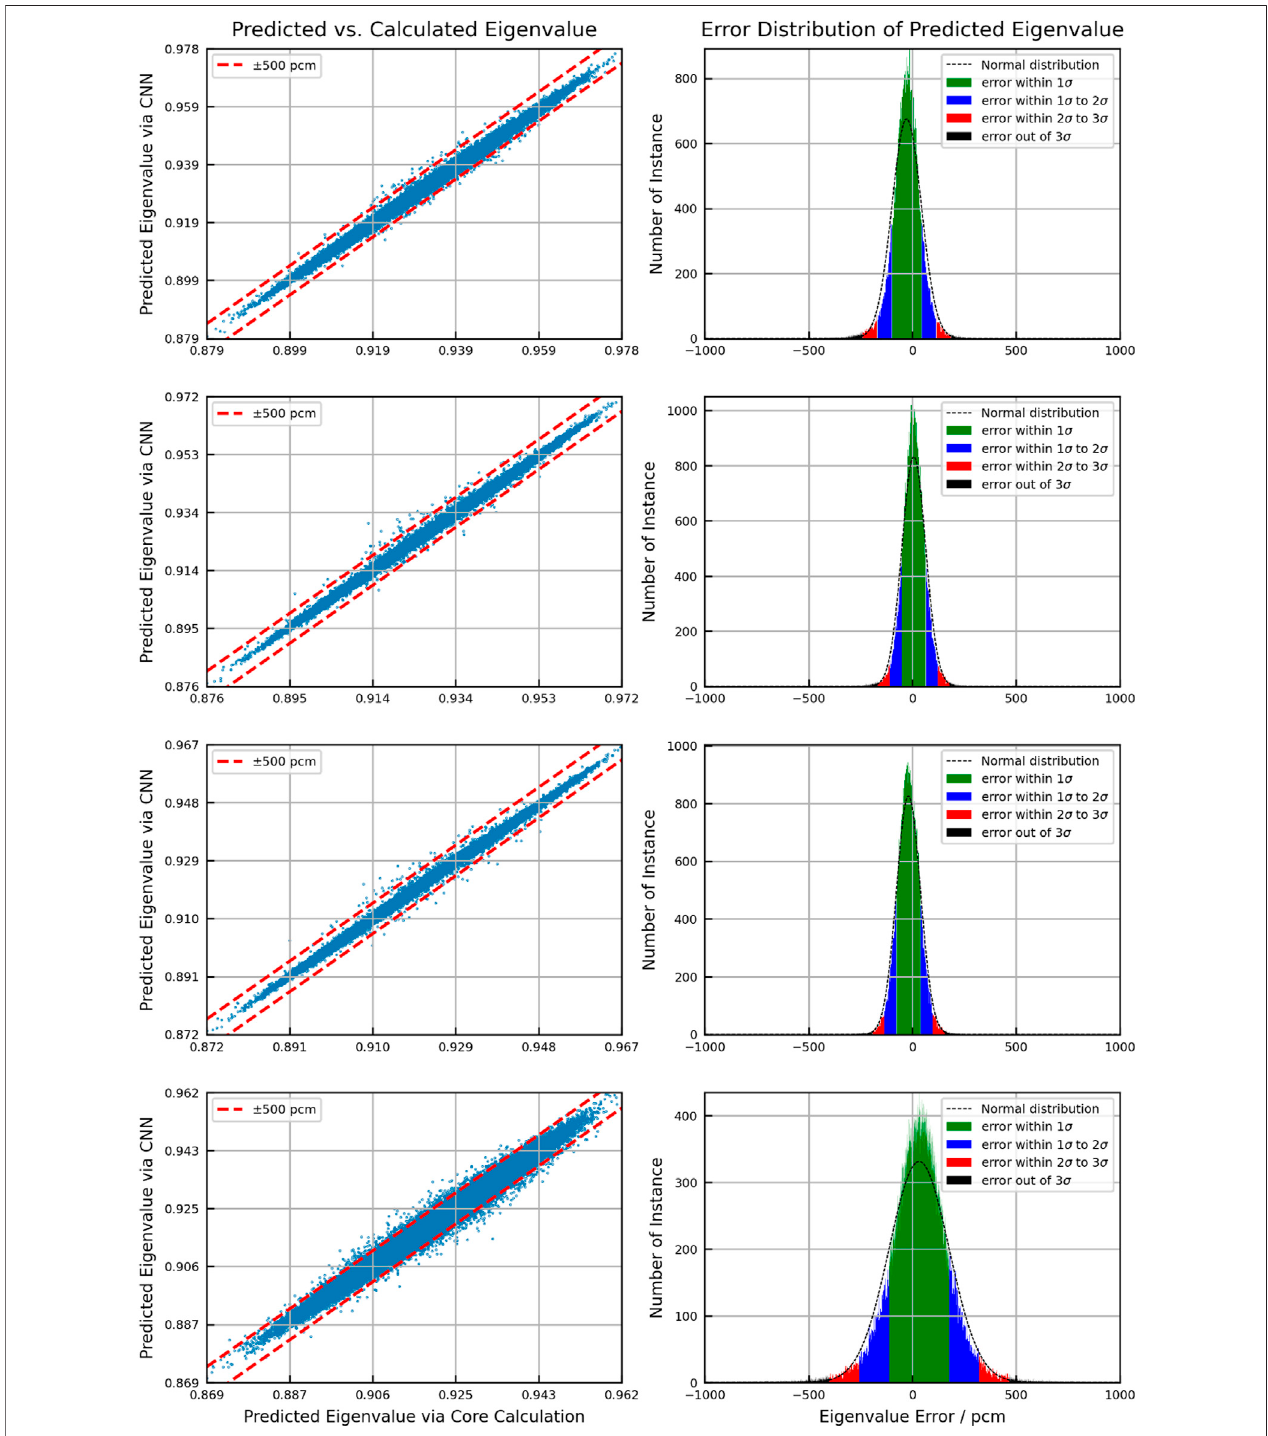
FIGURE 8 | Eigenvalue predicted accuracy of the